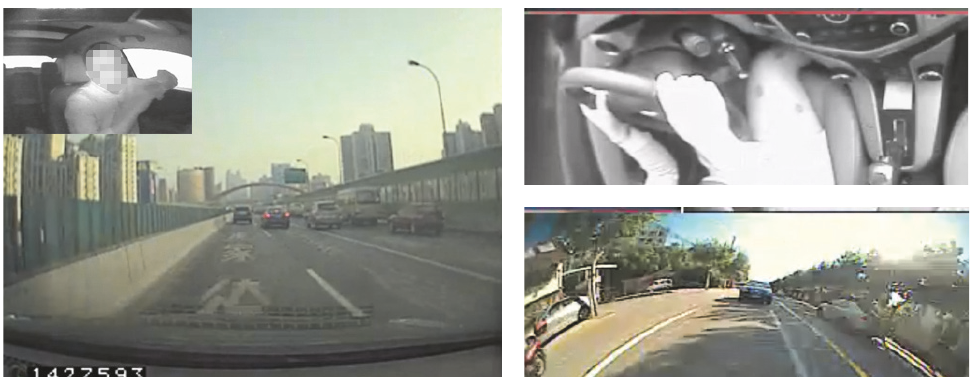
Figure 1: Four camera views in SH-NDS data acquisition system: forward view (left), in-cabin driver face view (upper left), instrument panel and steering wheel view (upper right), and rear view (bottom right).